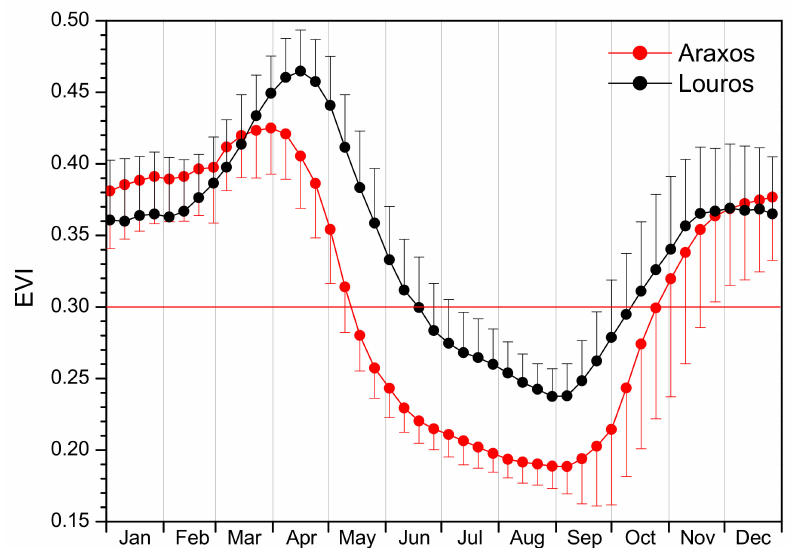
Figure 4. Annual EVI profile for the two study sites as average ± SD from the 21-year study period data. The red line marks EVI = 0.3, the value which was defined as the threshold for dry period onset and